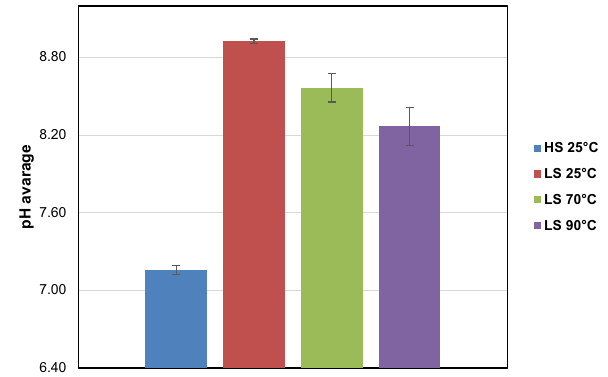
Fig. 12 Error bars for pH